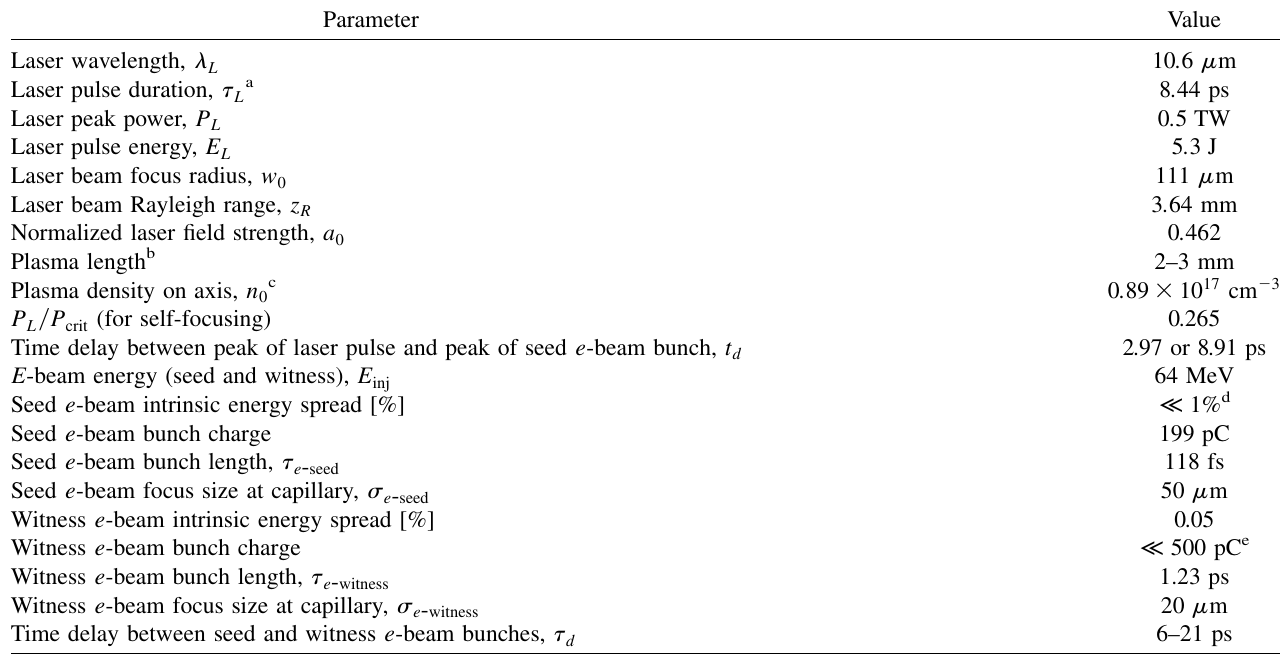
TABLE I. Laser and plasma parameters used in seeded SM-LWFA simulations. Parameter